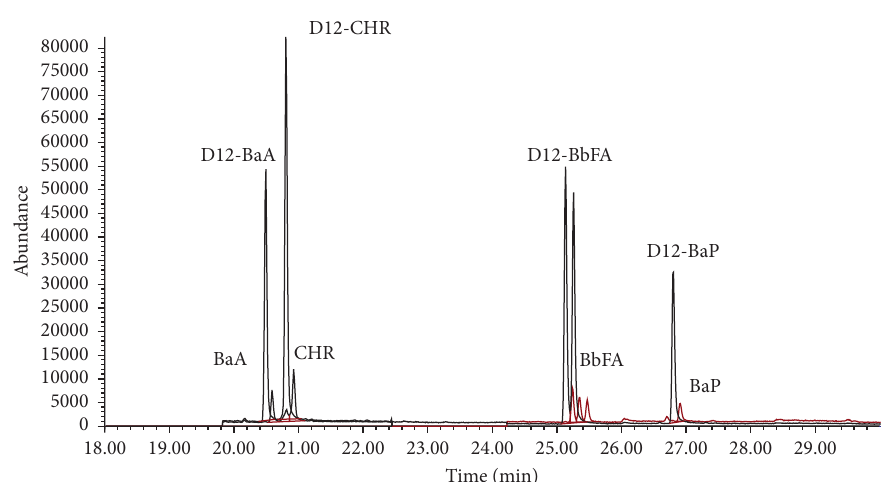
Figure 4: Chromatograph of PAH4 in an infant formula powder sample spiked with 1.0 μ g/kg PAH4 standard.